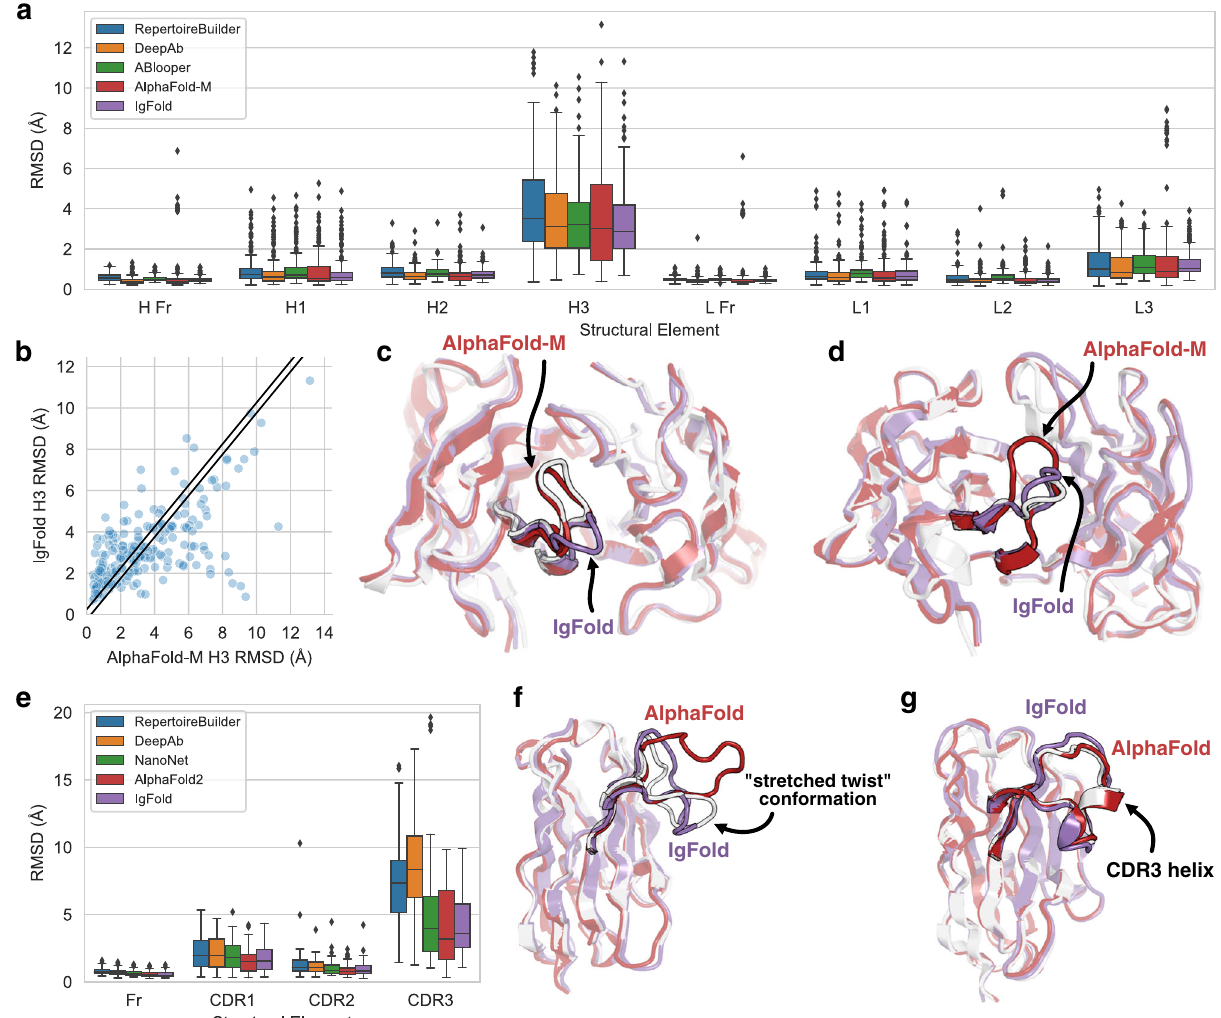
Fig. 2 | Comparison of methods for antibody structure prediction. All root- mean-squared-deviation (RMSD) values calculated over backbone heavy atoms after alignment of the respective framework residues. Box plots have center at median, bounds indicating interquartile range (IQR), whisker length of 1.5×IQR, andpoitnsoutsideof1.5×IQRrangeshownasoutliers.Sourcedataareprovidedas a Source Data fi le. a Benchmark performance of RepertoireBuilder, DeepAb, ABlooper,AlphaFold-Multimer,andIgFoldforpairedantibodystructureprediction ( n =197 structure predictions). b Per-target comparison of CDR H3 loop structure prediction for IgFold and AlphaFold-Multimer, with each point representing the RMSD H3 for both methods on a single benchmark target. c Comparison of